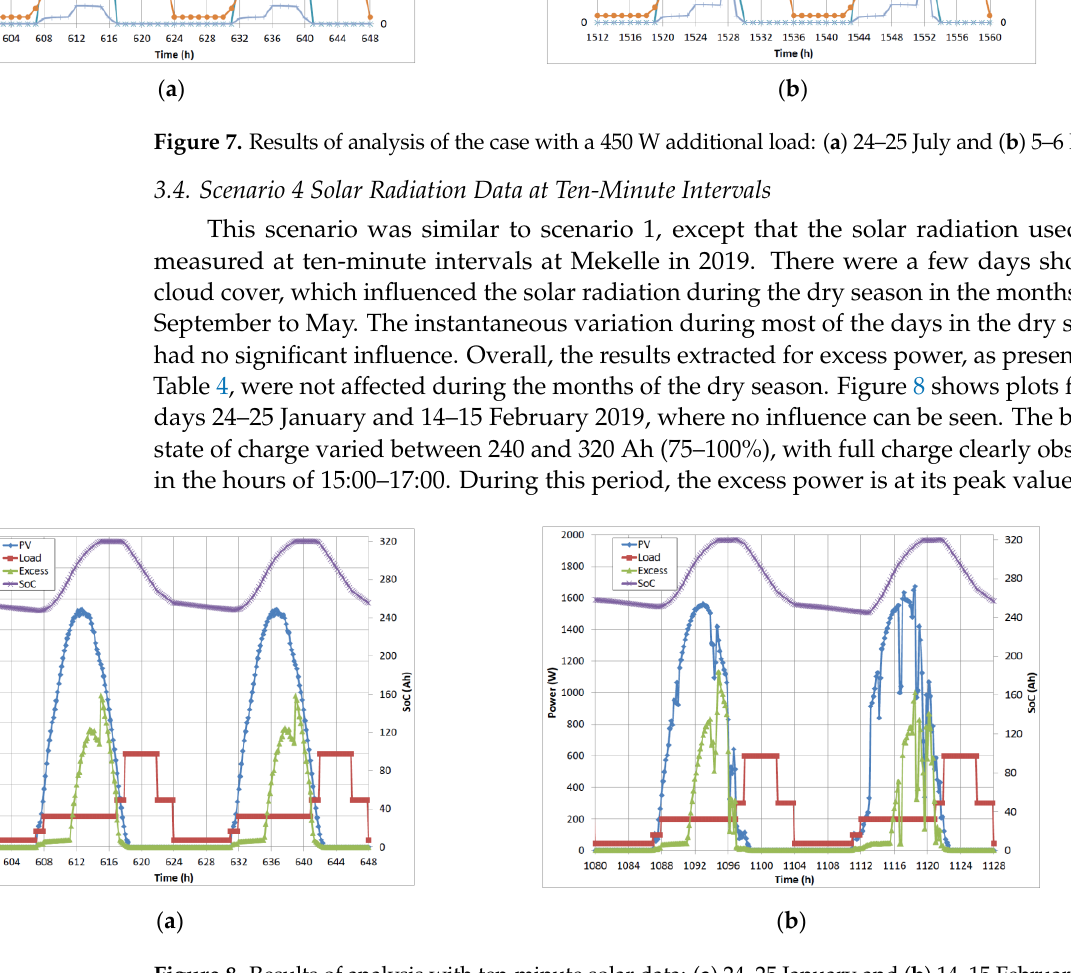
Figure 8. Results of analysis with ten-minute solar data: ( a ) 24 – 25 January and ( b ) 14 – 15 February 2019.